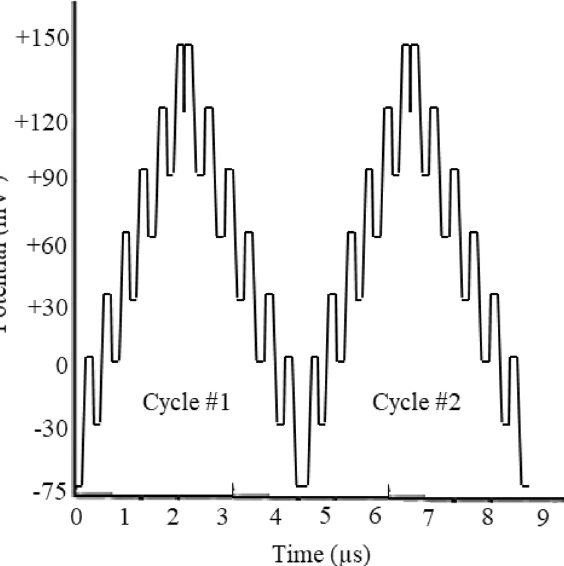
Figure 6. Smoothed curve-fitted waveforms as optimum AP’s potential AC firing stimulus at VLF region at two sequential AP cycles at the hyperpolarization zones. The potentials were estimated by potentiometry versus pseudo reference micro-electrode at the giga seal conditions using the two micro-electrode